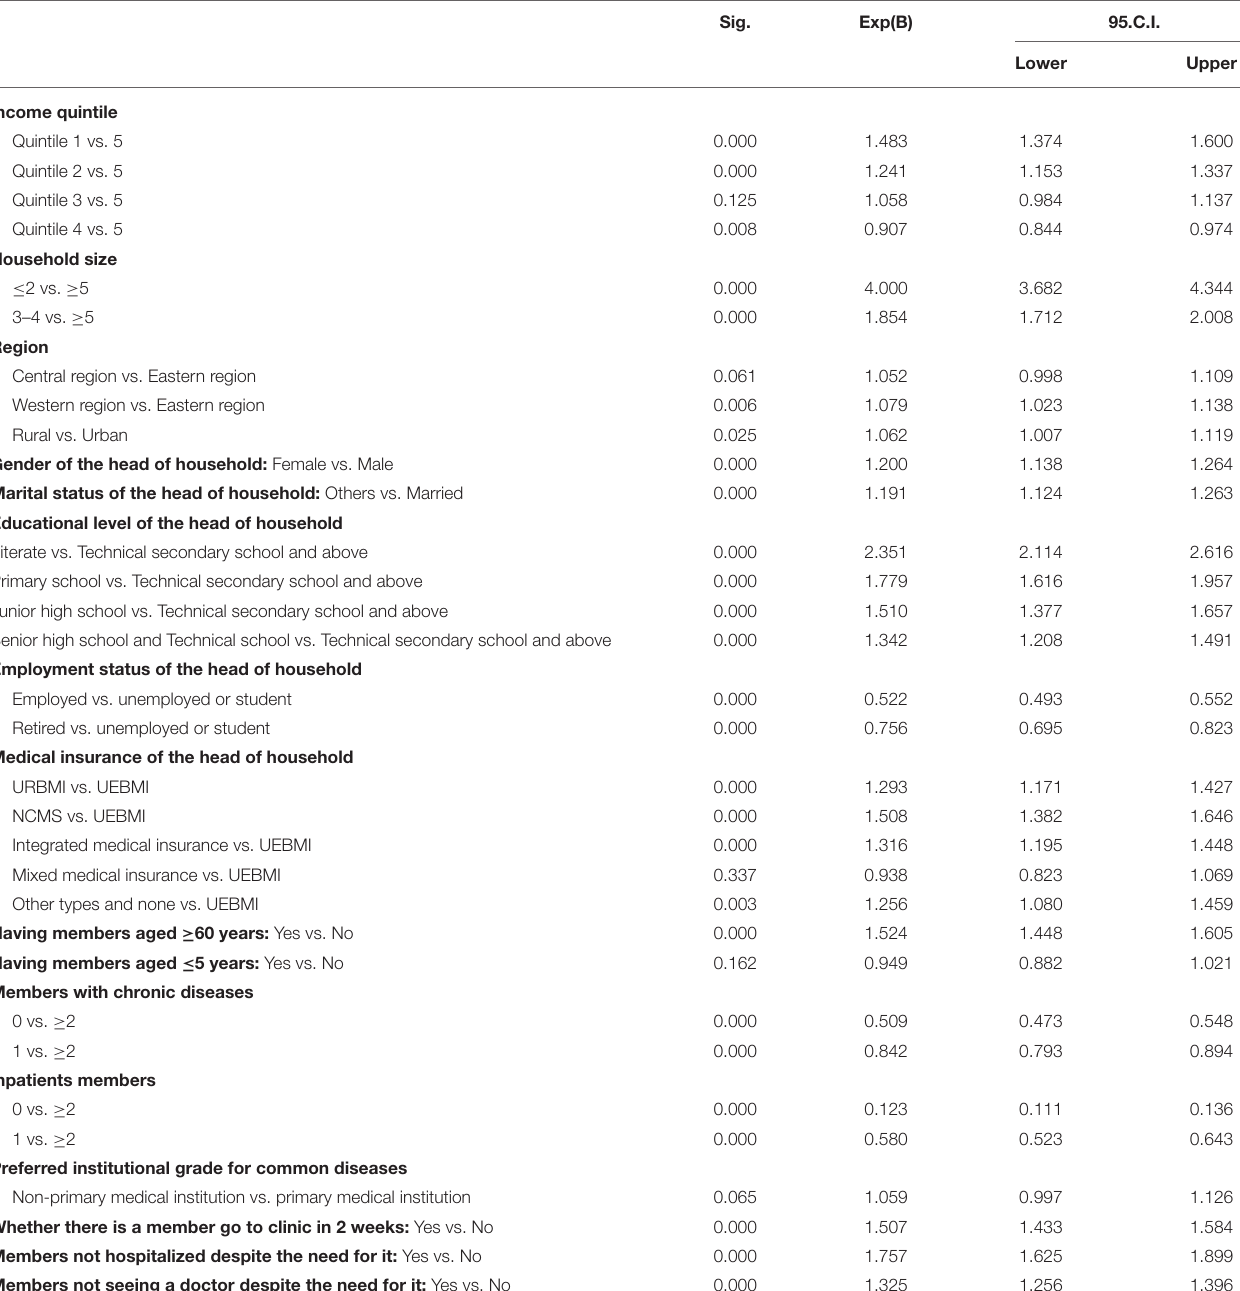
TABLE 4 | Determinants of CHE, using logistic regression.